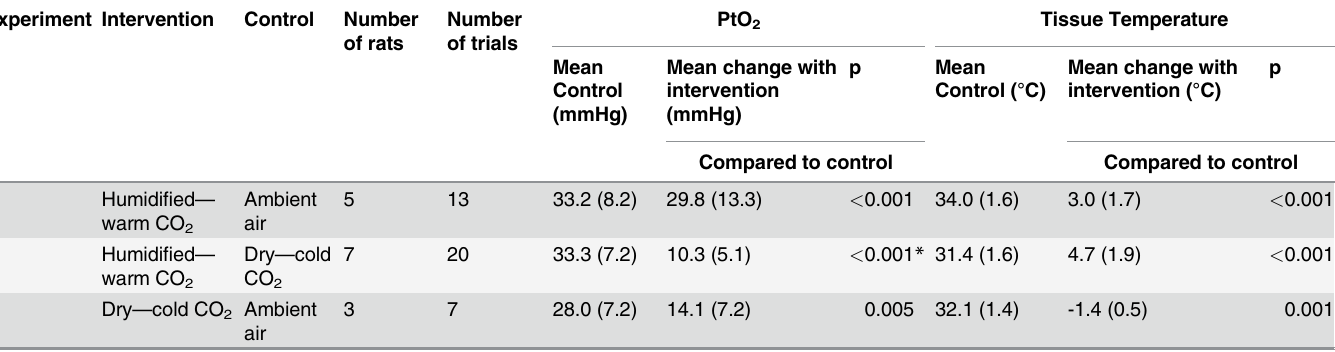
Table 1. Tissue oxygen tension (PtO 2 ) and tissue temperature results for each experiment. Experiment